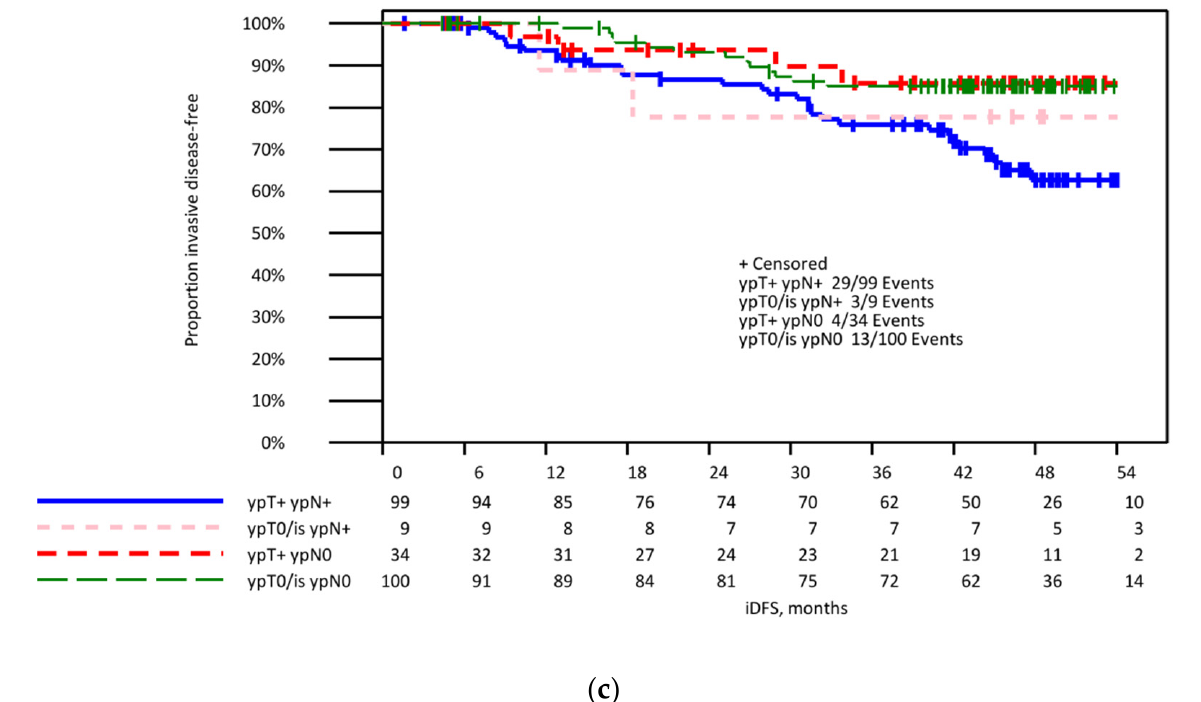
Figure 1. Invasive disease-free survival in patients with initially lymph node-positive breast cancer. ( a ) In patients with pcR (ypN0), respectively, non-pCR (ypN+) in lymph nodes after neoadjuvant systemic treatment. ( b ) According to the pCR in breast and nodes (ypT0/is ypN0), after neoadjuvant systemic treatment. ( c ) Invasive disease-free survival in patients with initially lymph node-positive breast cancer according to the pCR in breast (ypT0/is) and nodes (ypN0) after neoadjuvant systemic treatment.